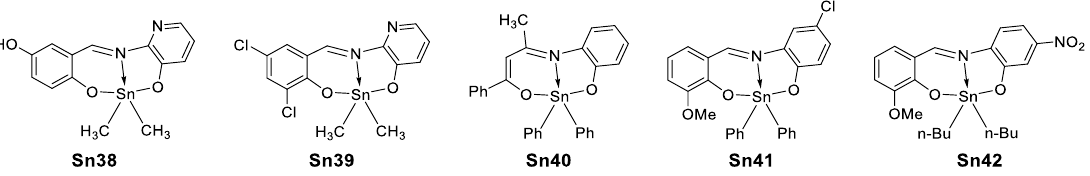
Figure 45. Hexacoordinated tin compounds.